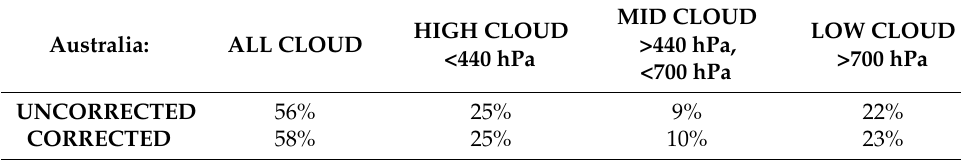
HIRS/2 sensor series showing uncorrected results and those corrected for orbit drift. The statistics categorise differing cloud height observations over